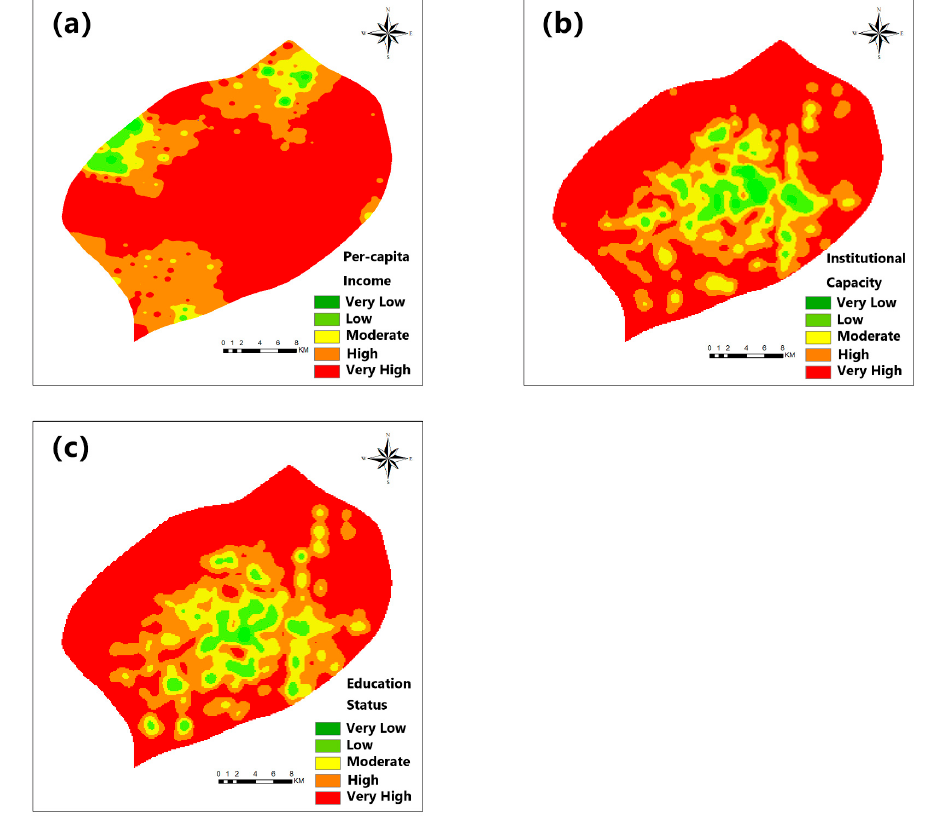
Figure 6. Per capita income ( a ); institutional capacity ( b ); education status ( c ).